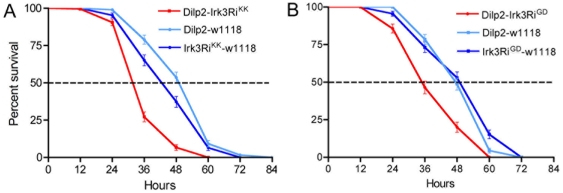
Knockdown of an inward rectifying K-channel mimics GABAB receptor knockdown.Two different UAS-Irk3-RNAi lines (Irk3RiKK and Irk3RiGD) were crossed to Dilp2-Gal4 flies and tested for survival at starvation. Both crosses resulted in flies that survived significantly shorter than parental controls. A. Dilp2-Irk3RiKK flies (p<0.001; n = 169–180 for each genotype; three replicates). B. Dilp2-Irk3RiGD flies (p<0.001; n = 140–158; 3 replicates).